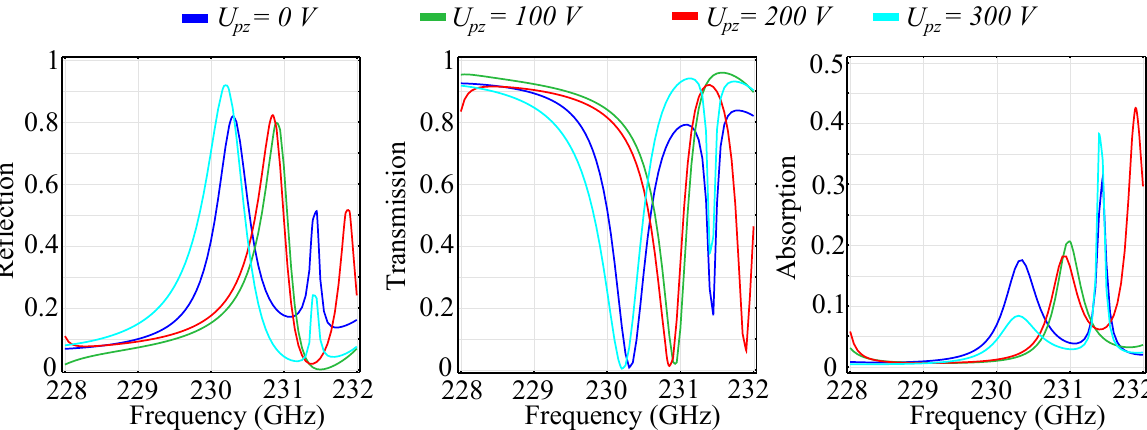
Figure 12. The reflected, transmitted, and absorbed waves for fixed values of the piezoelectric voltage applied longitudinally across the unit cell, in the silicon substrate unit cell